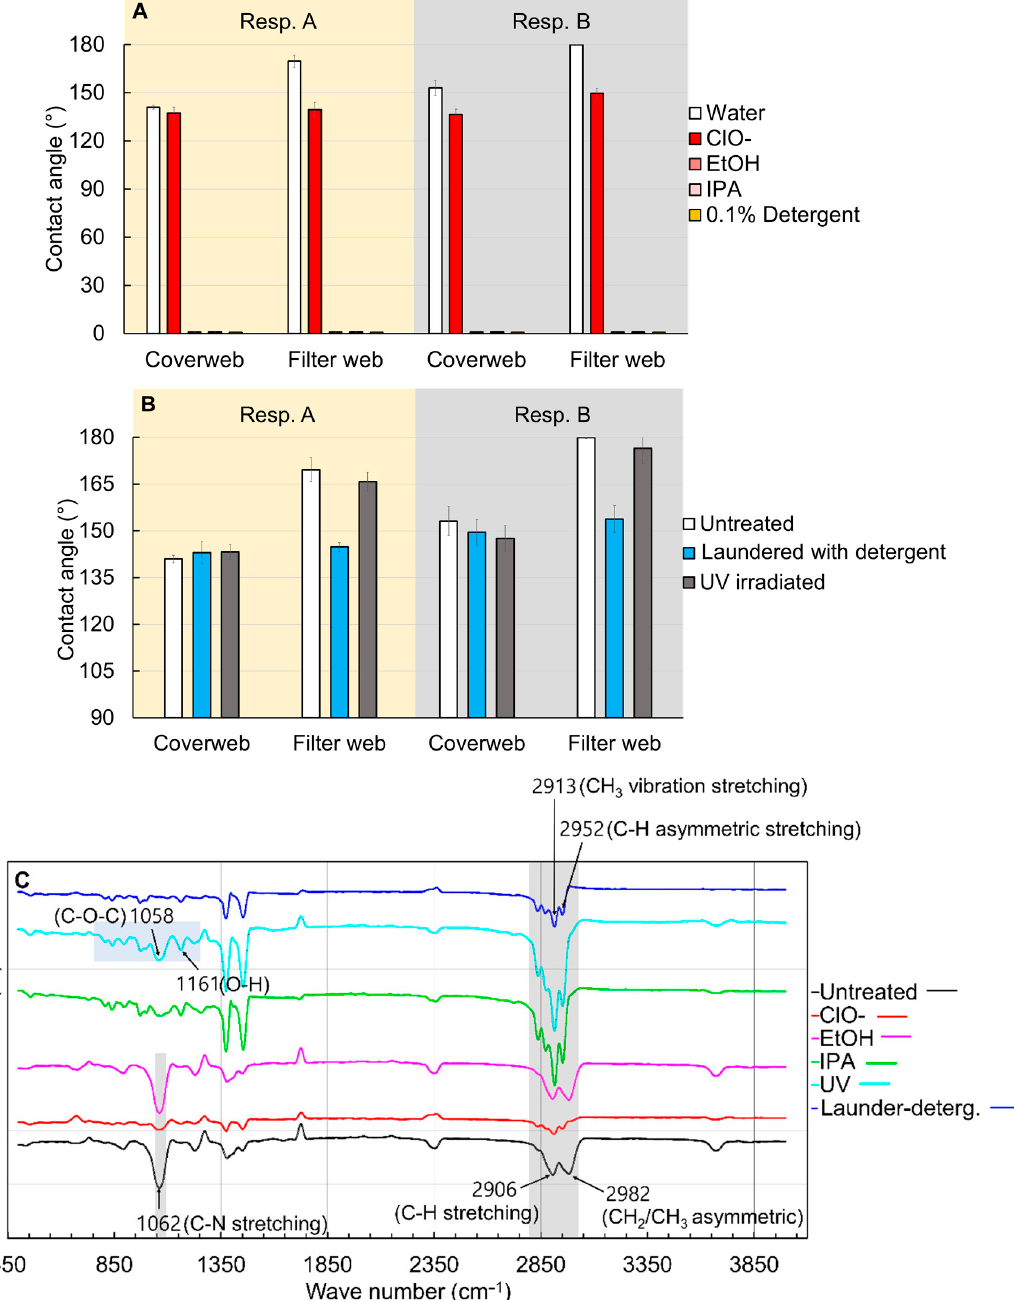
Figure 4. Wettability and chemistry of webs with different treatments. ( A ) Contact angle of various liquids on the coverweb and filter web, ( B ) water contact angle, and ( C ) FTIR-ATR transmittance of the differently-treated media. Contact angles were measured in 60 s upon placing the liquid drop. For EtOH, IPA, and detergent solution, the contact angles were 0°.